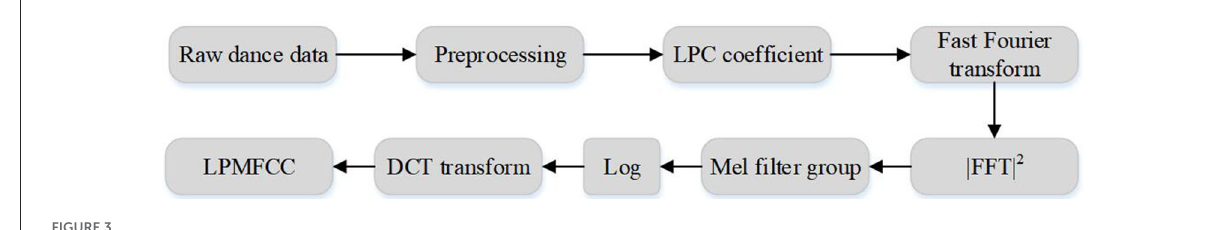
FIGURE3 LPMFCC parameter feature extraction process.